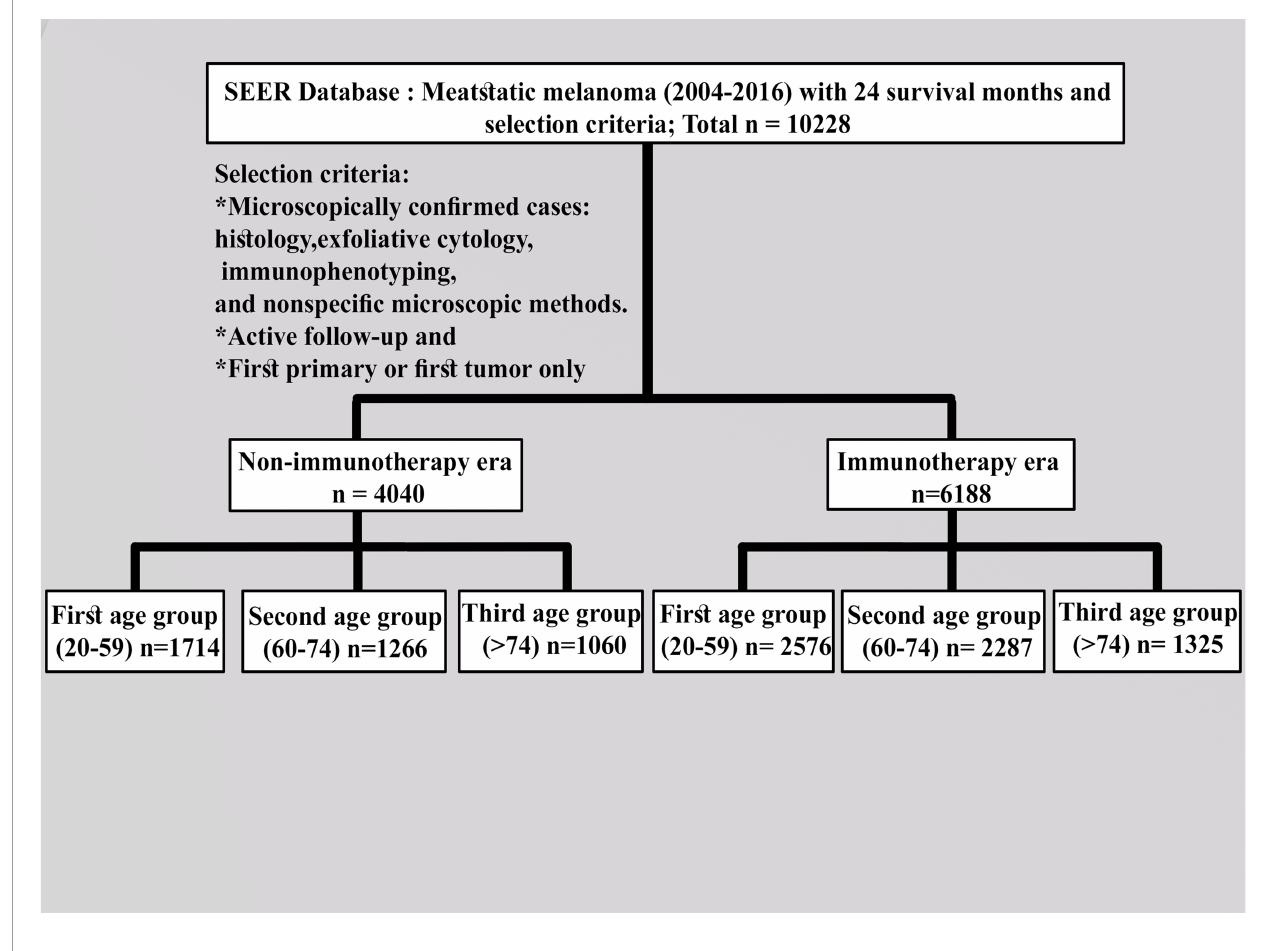
FIGURE 1 | Detailed description of the inclusion